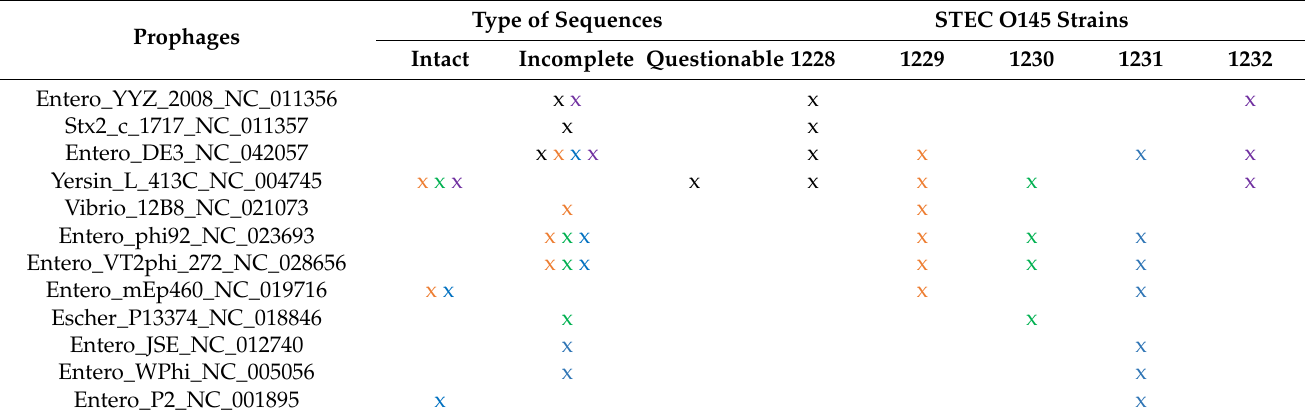
Table 4. Phage sequences classified according to the PHASTER scores as intact, questionable, and incomplete >90, 70–90, <70,